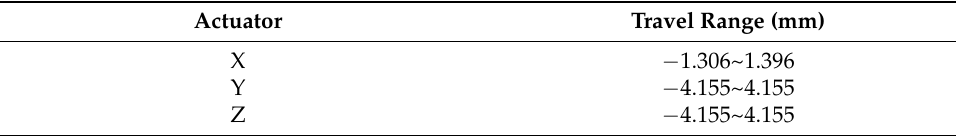
Table 3. Travel ranges of actuators X, Y, and Z.